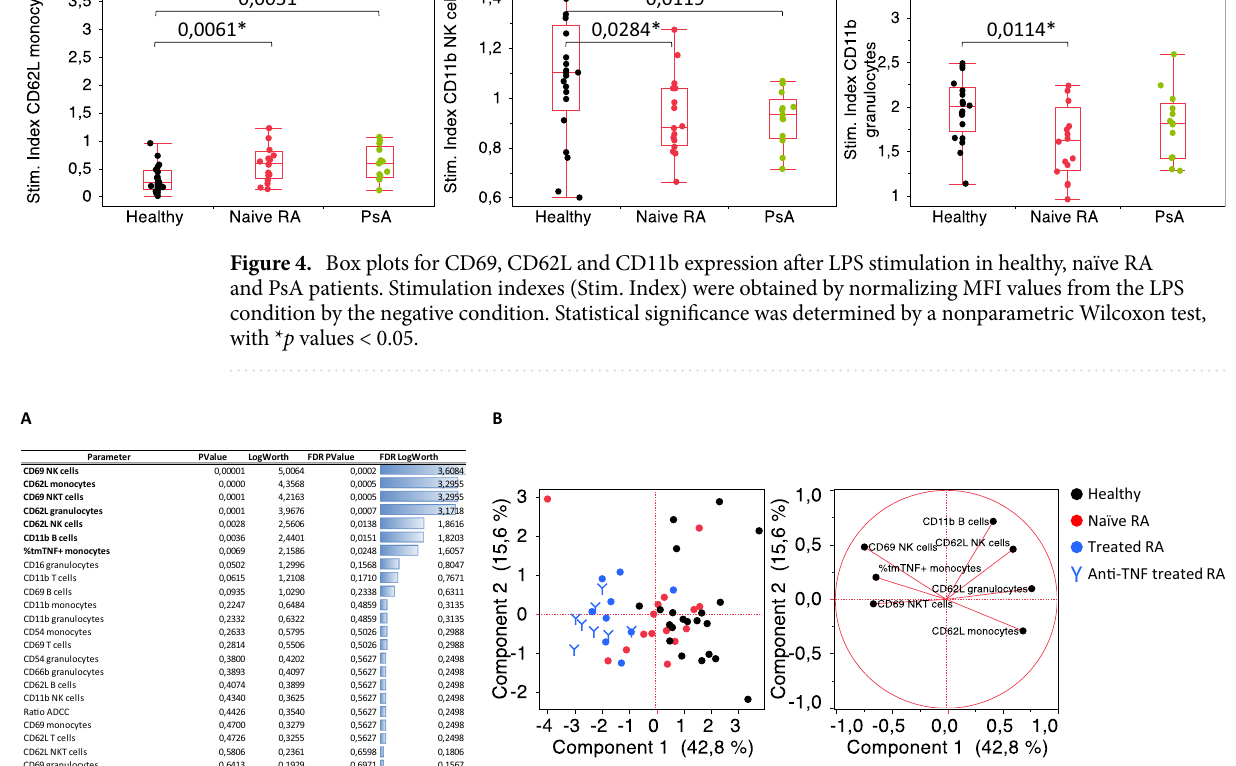
Healthy Naïve RA Treated RA Y An(cid:31)-TNF treated RA